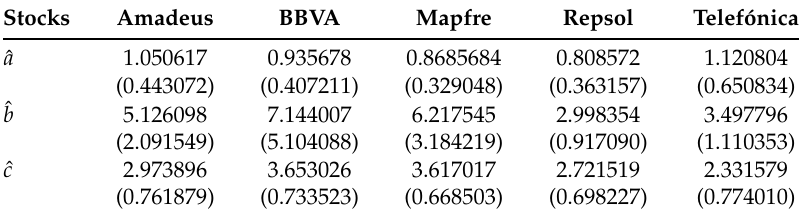
Table 3. Maximum likelihood estimates for the skewed t model of Type 2, standardized data. Standard errors are in